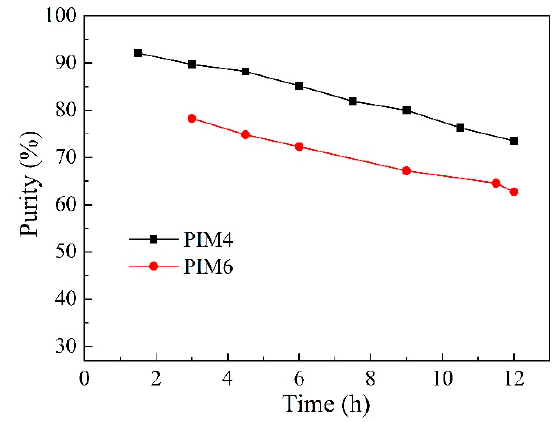
Figure 3. The purity of hexanoic acid in the stripping solution (PIMs: PIM4 and PIM6; Feed solution: 0.01 mol L − 1 acetic acid +0.01 mol L − 1 hexanoic acid, pH = 6; Stripping solution: 0.1 mol L − 1